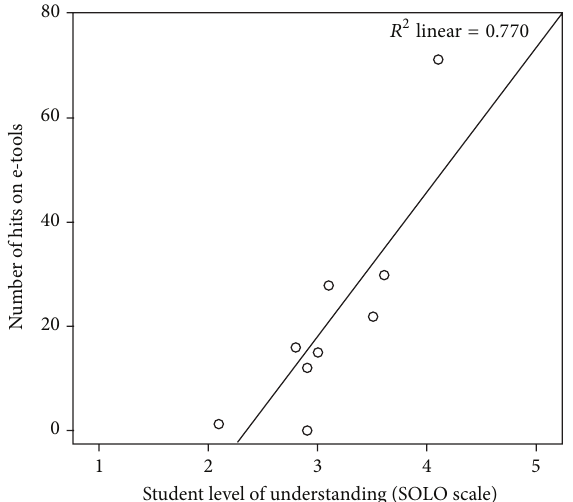
Figure 2: Scatterplots showing the number of hits on e-learning tools and student level of understanding in the related questions for the course 3028PHM (semester two, 2012). Student level of understanding is categorised according to SOLO taxonomy into five levels: (1) prestructural, (2) unistructural, (3) multistructural, (4) relational, and (5) extended